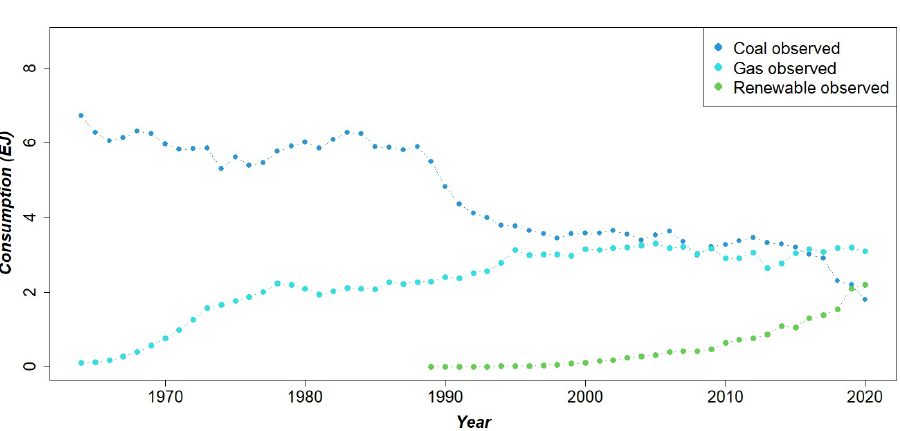
Figure 1. Time series of energy consumption of coal, gas and renewables in Germany